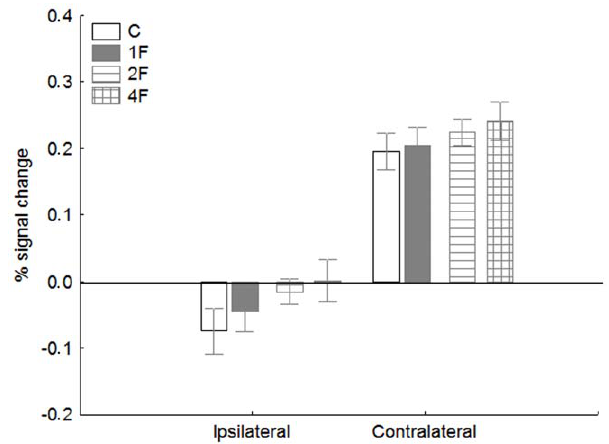
Figure 8. Average peak activation profiles ( ± standard error) of the early visual cortex (EVC, averaged across hemispheres) for the ipsilateral and contralateral stimulations. For conventions see Fig.